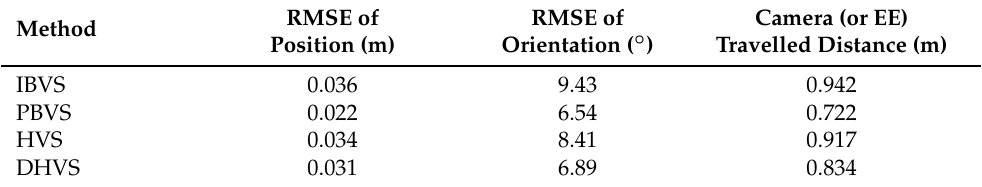
Table 2. Performance of visual servoing methods in the Cartesian